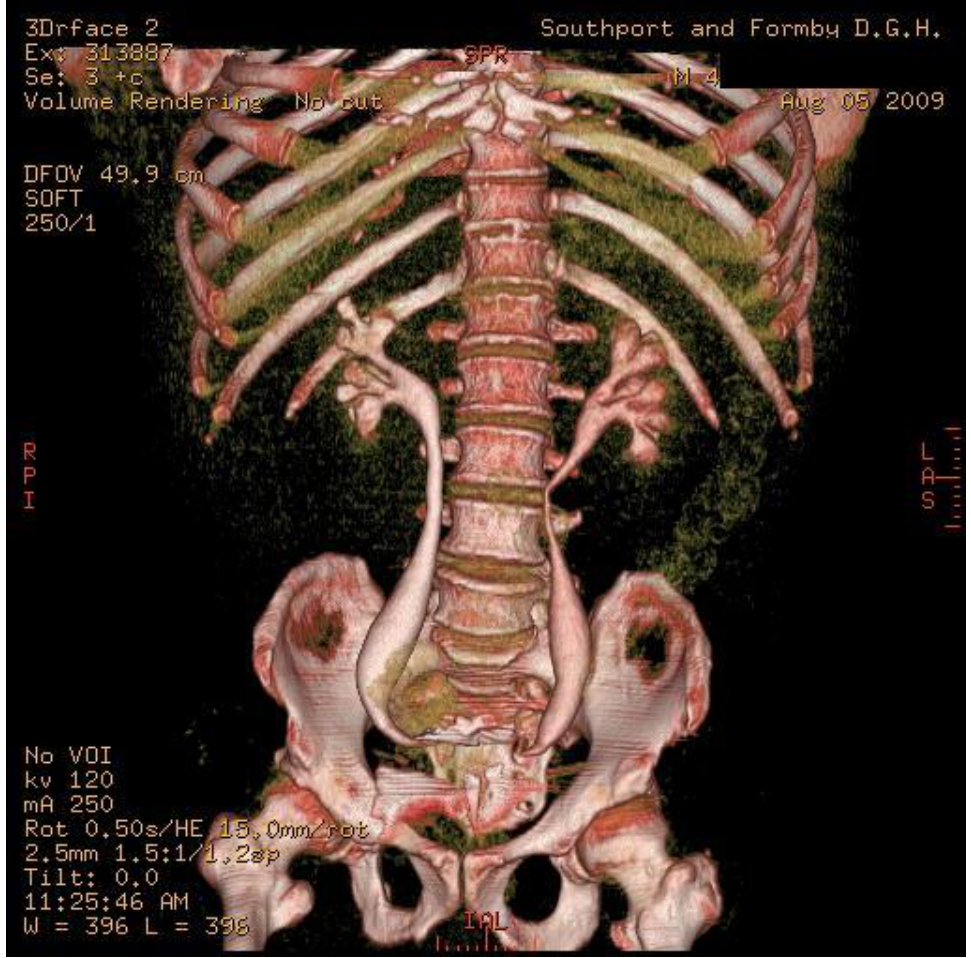
FIGURE 1 . Surface rendered CT reformatted image of the abdomen in coronal plane, showing the “hooked” course of the lower